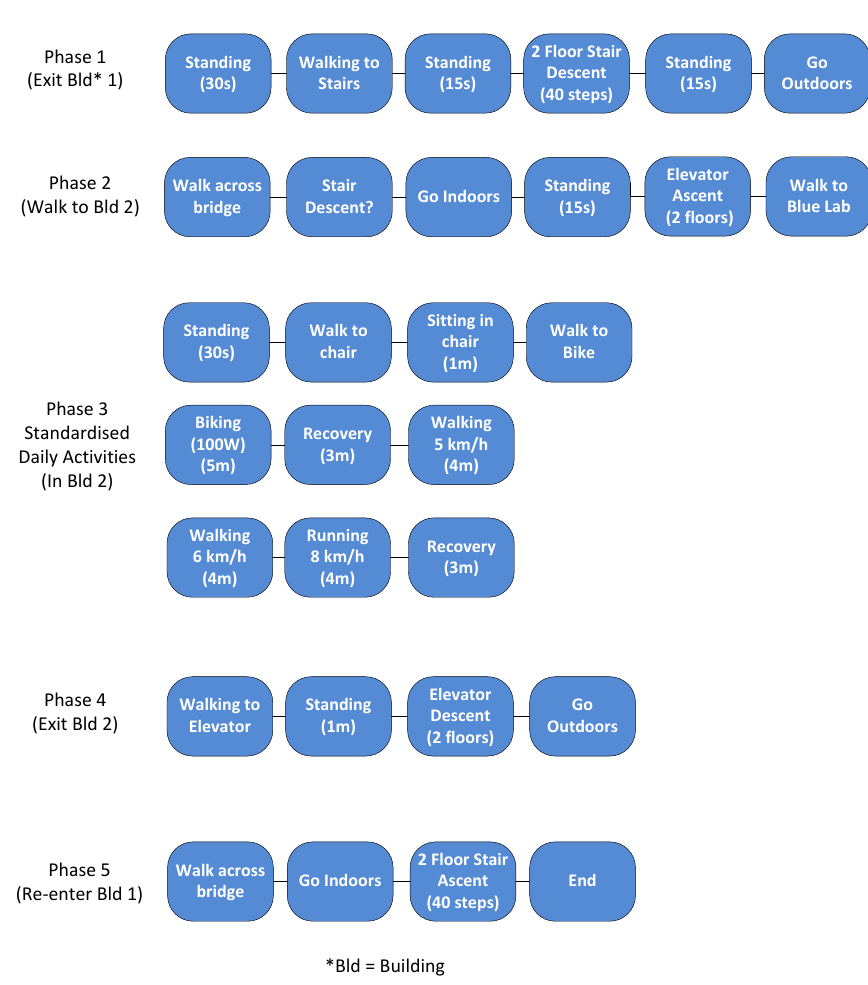
Figure 4. Protocol used in feasibility